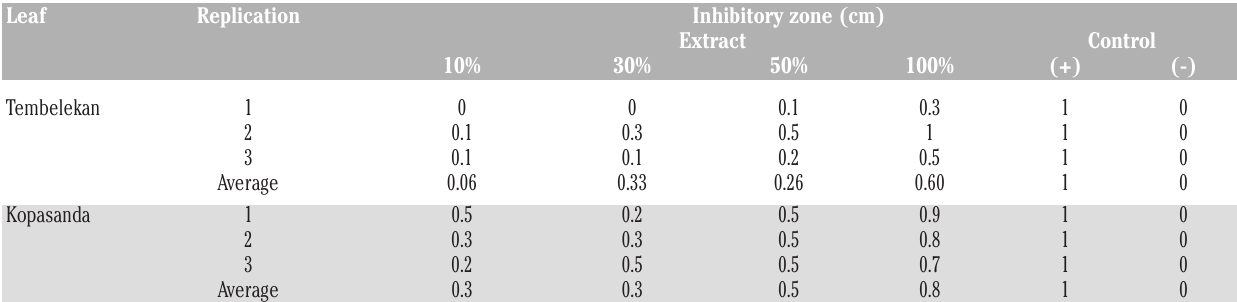
Table 1. The sensitivity of Tembelekan ( L. camara L.) and Kopasanda ( C. odorata L) leafs extract to S. aureus bacteria. Leaf Replication Inhibitory zone (cm)